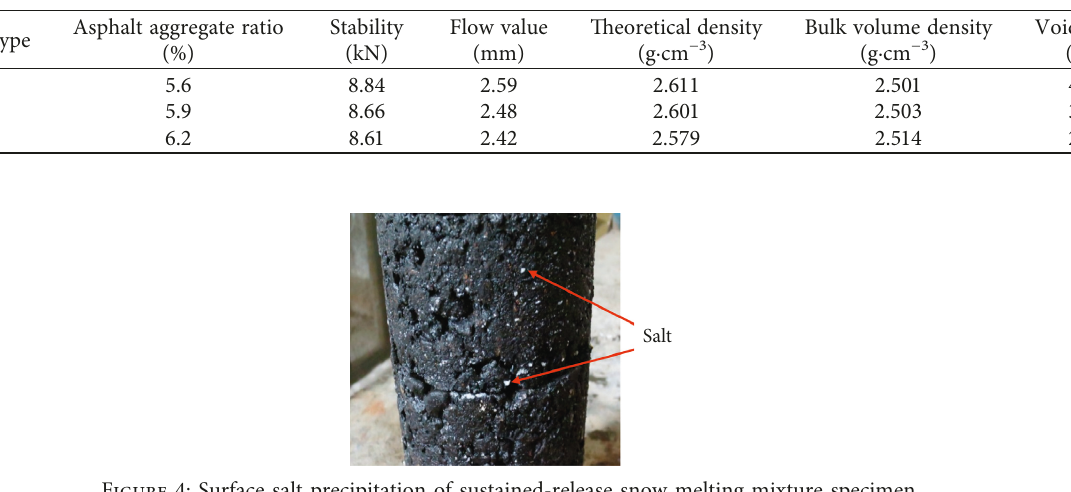
Table 3: Marshall design parameters.